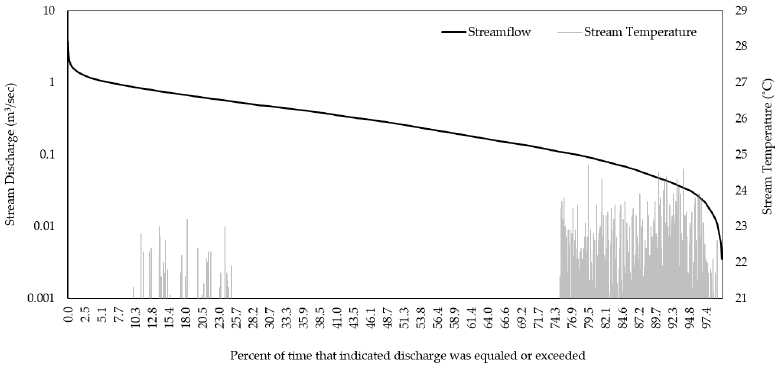
Figure 5. Beaver River simulated historical flow duration curve and stream temperatures. The secondary y-axis begins at 21 °C and any temperatures that are not above the stressful threshold are not shown in the figure. The stream temperatures in the Q25–Q75 range are omitted from the figure.